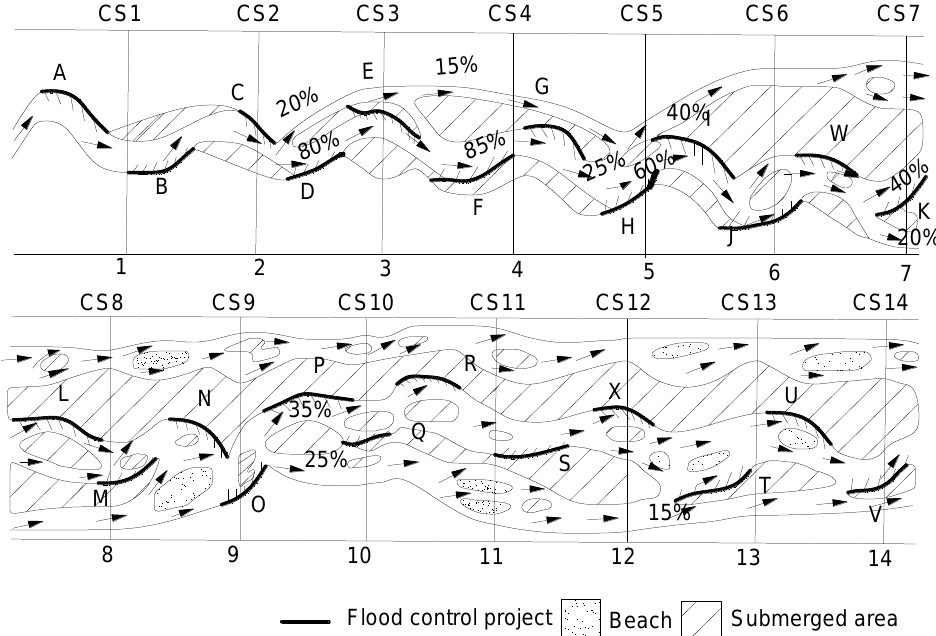
Figure 4. River regime after 6 h of water release in group N2 test.